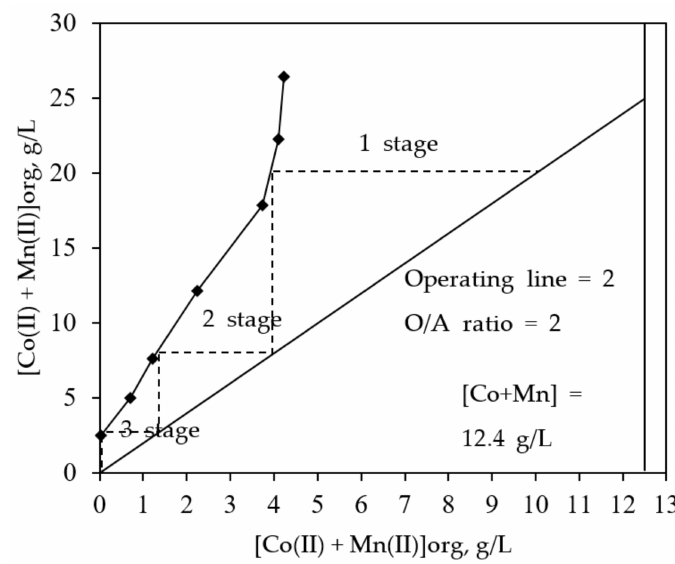
Figure 6. McCabe-Thiele diagram for Co and Mn stripping by 50 vol % acetic